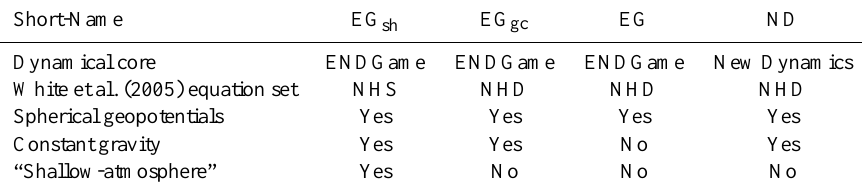
Table 2. Table showing the name used in this work with the dynamical core, the name for the equation set (as described in White et al., 2005) and the main included assumptions. For a full description of the underlying equations see White et al. (2005).